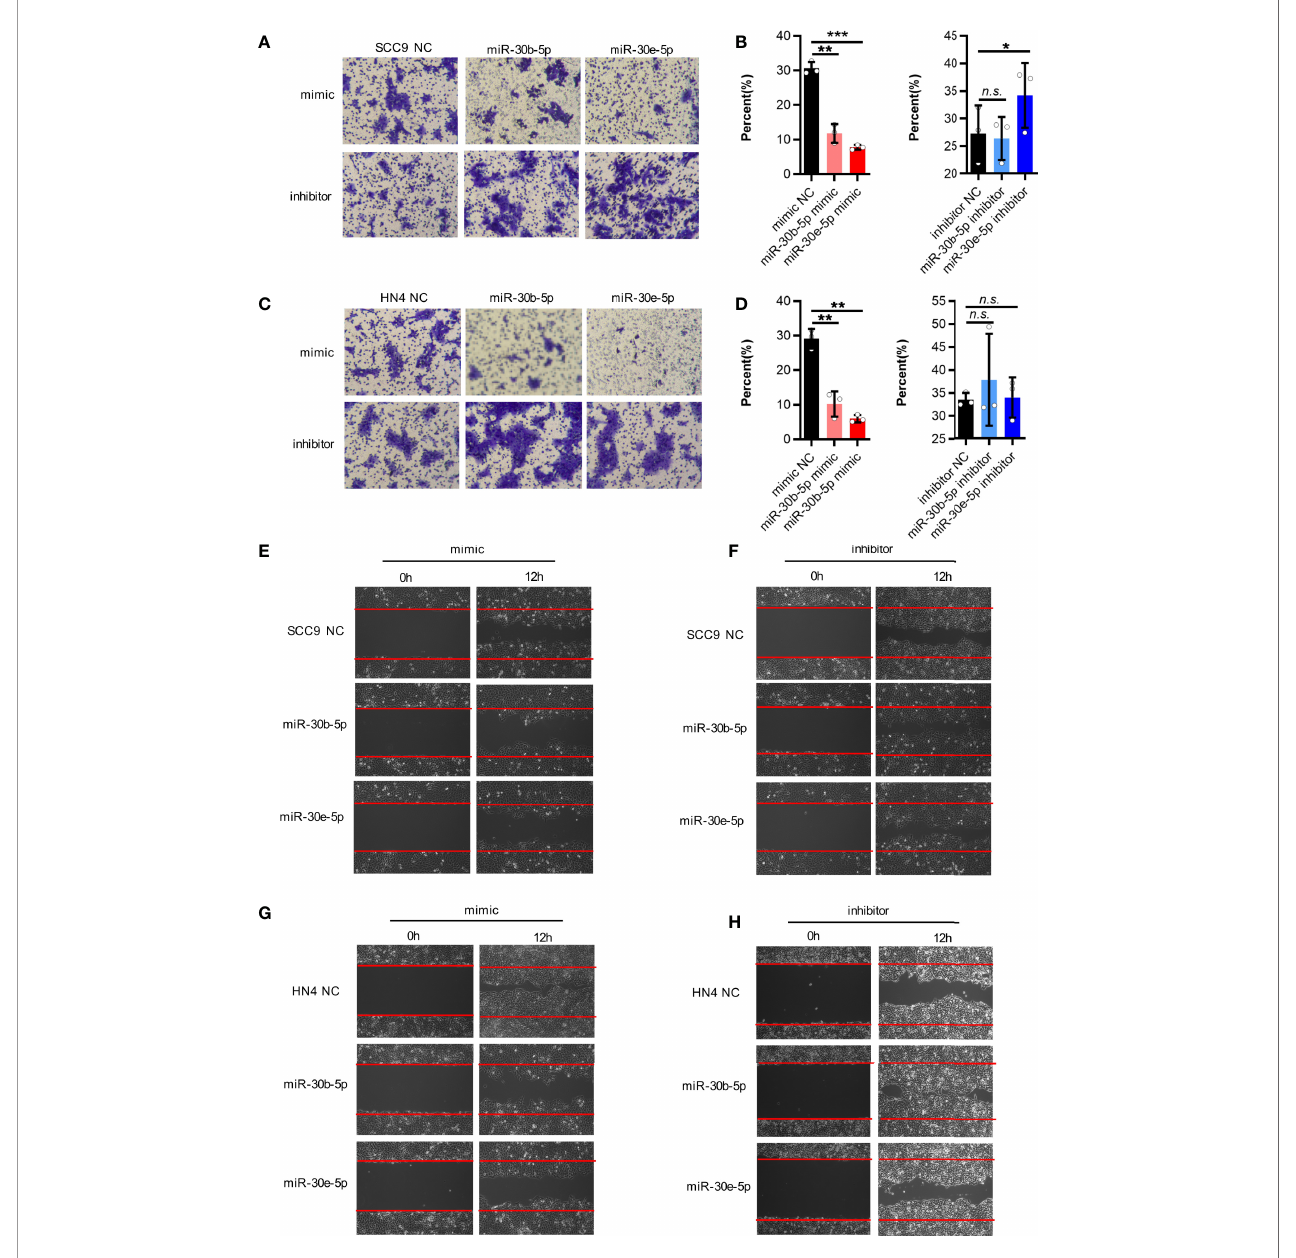
FIGURE 4 | The migration of SCC9 and HN4 cells were depressed by miR-30b-5p or miR-30e-5p. (A, B) MiR-30b-5p or miR-30e-5p in fl uenced SCC9 cell migration. (C, D) MiR-30b-5p or miR-30e-5p in fl uenced HN4 cell migration. (E, F) MiR-30b-5p or miR-30e-5p in fl uenced the rate of SCC9 cell wound closure. (G, H) MiR-30b-5p or miR-30e-5p in fl uenced the rate of HN4 cell wound closure. (* p <0.05, ** p <0.01, *** p <0.001, n.s., no signi fi